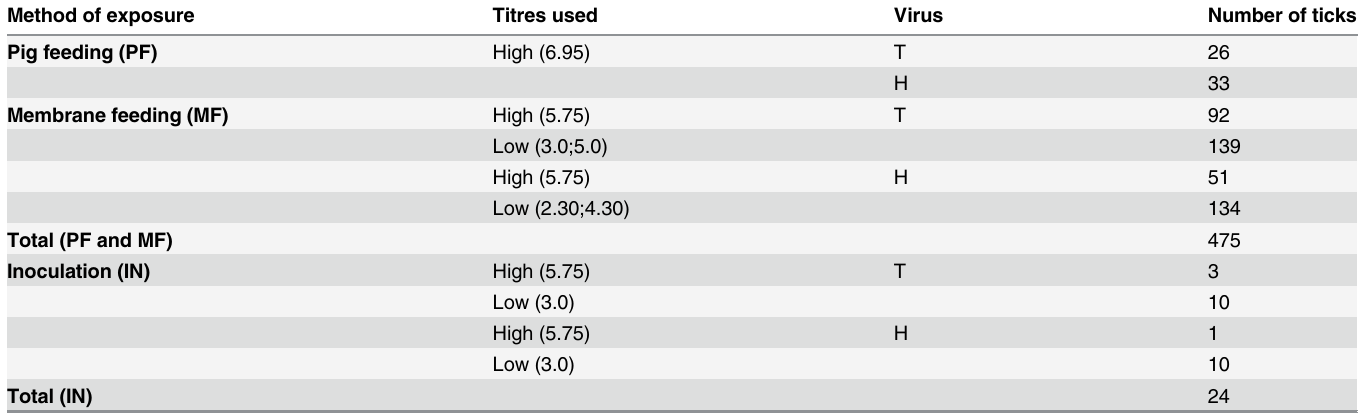
Table 1. Number of ticks exposed to ASFV summarized by method of exposure, virus titre and virus strain. Method of